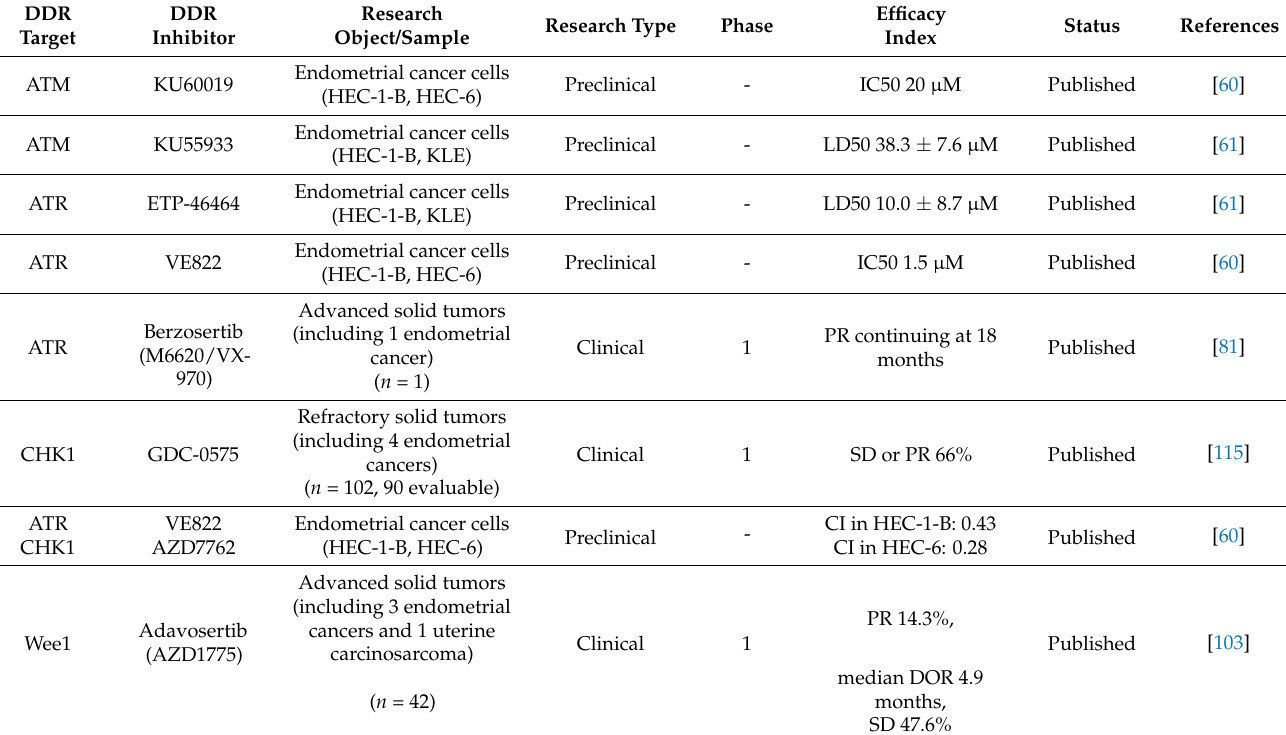
Table 2. Preclinical and clinical data of DNA damage response inhibitors in endometrial